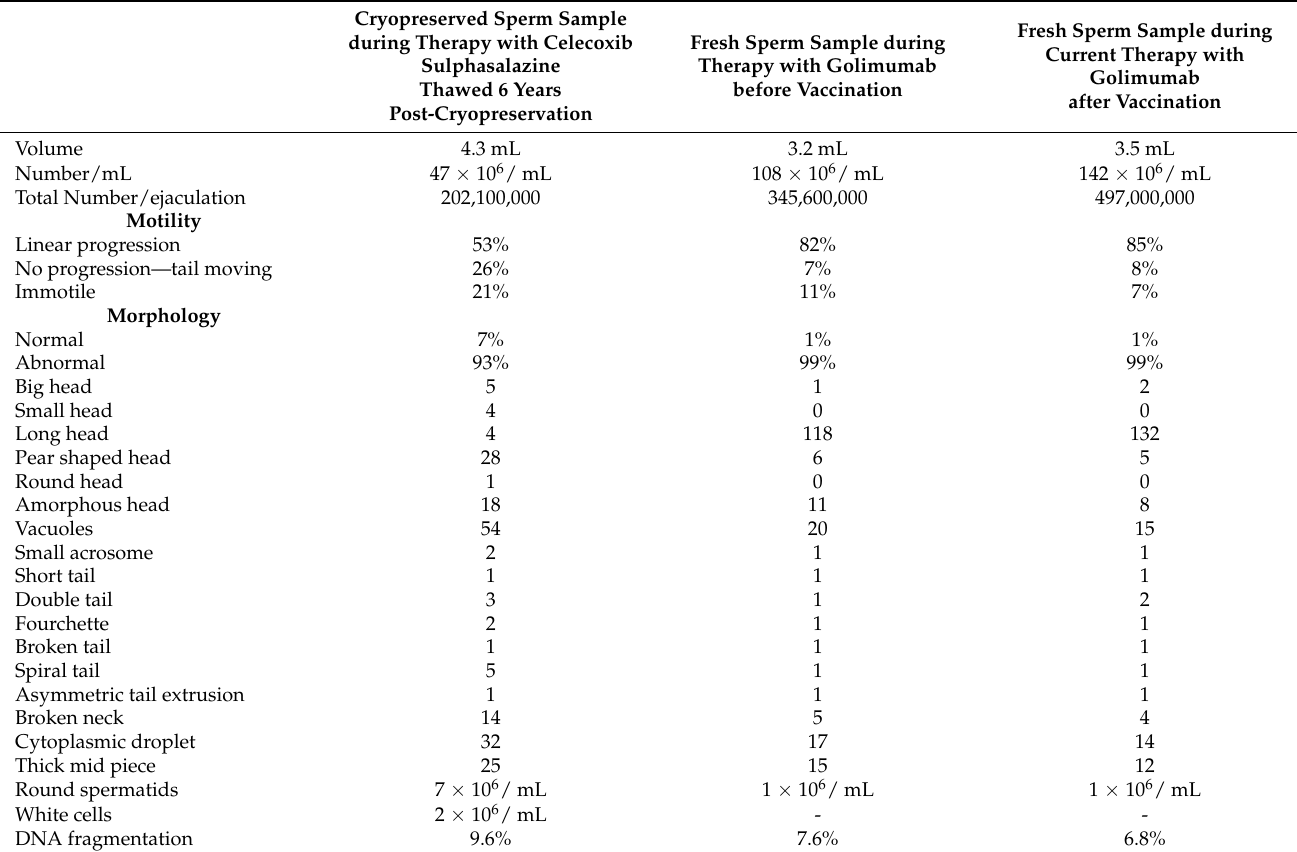
Table 1. Standard semen